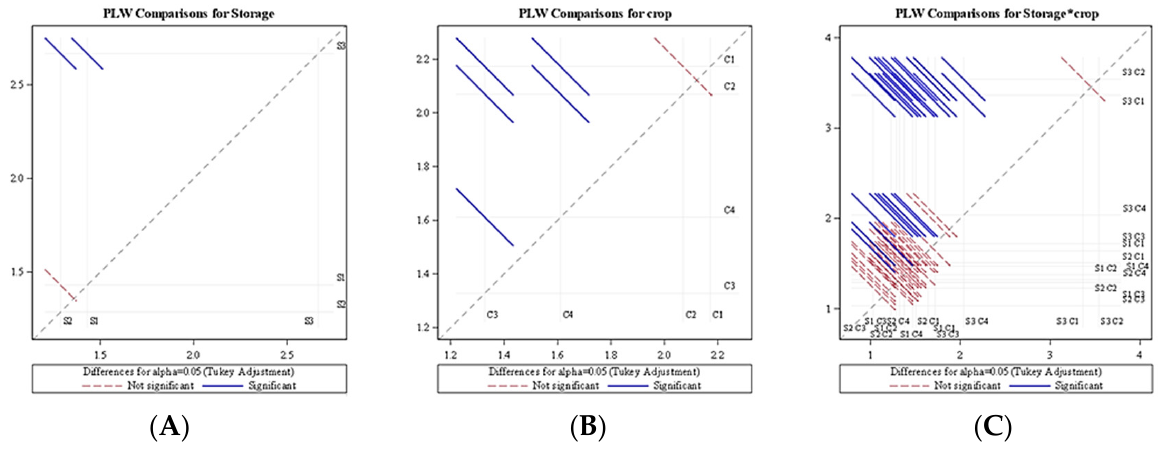
Figure 4. Diffogram showing the effect of storage condition and crop on the average daily change of PLW. ( A ) PLW comparison for storage ( B ) PLW comparison for crop ( C ) PLW comparison for storage*crop (S1—LCTR; S2—VCR; S3—ambient storage; C1—bitter gourd; C2—okra; C3—mango;